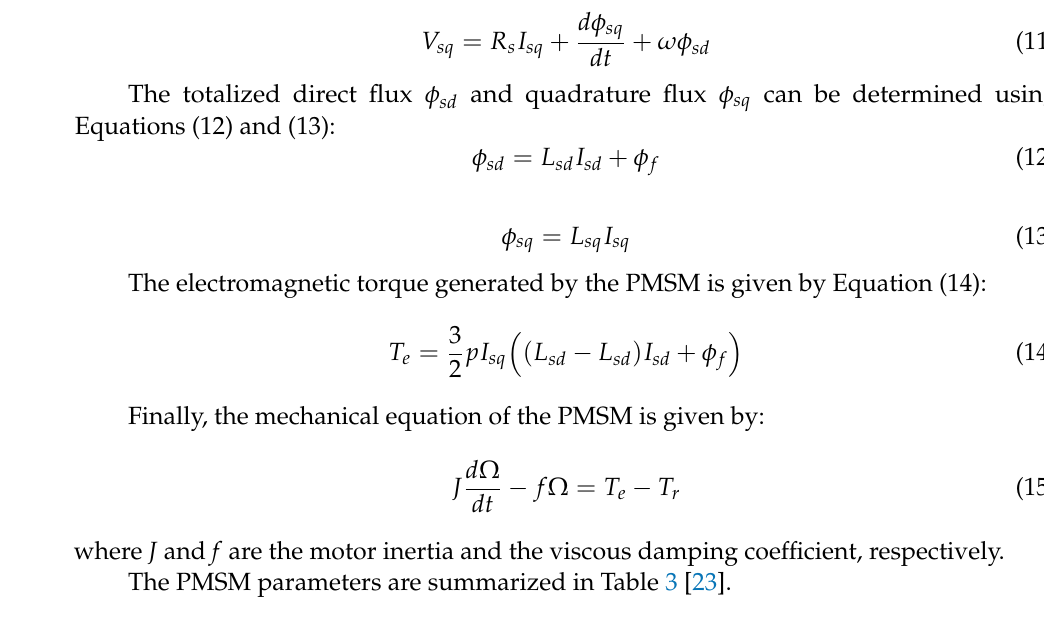
Table 3. PMSM parameters.